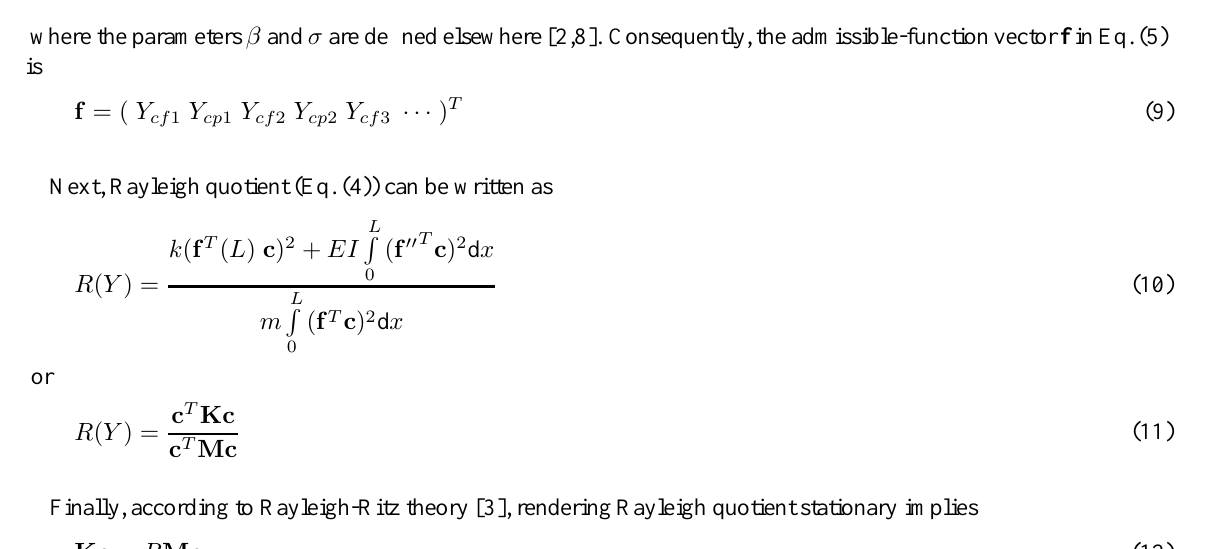
Fig. 7. FEM third eigenfunction convergence (4, 6, ... , 12